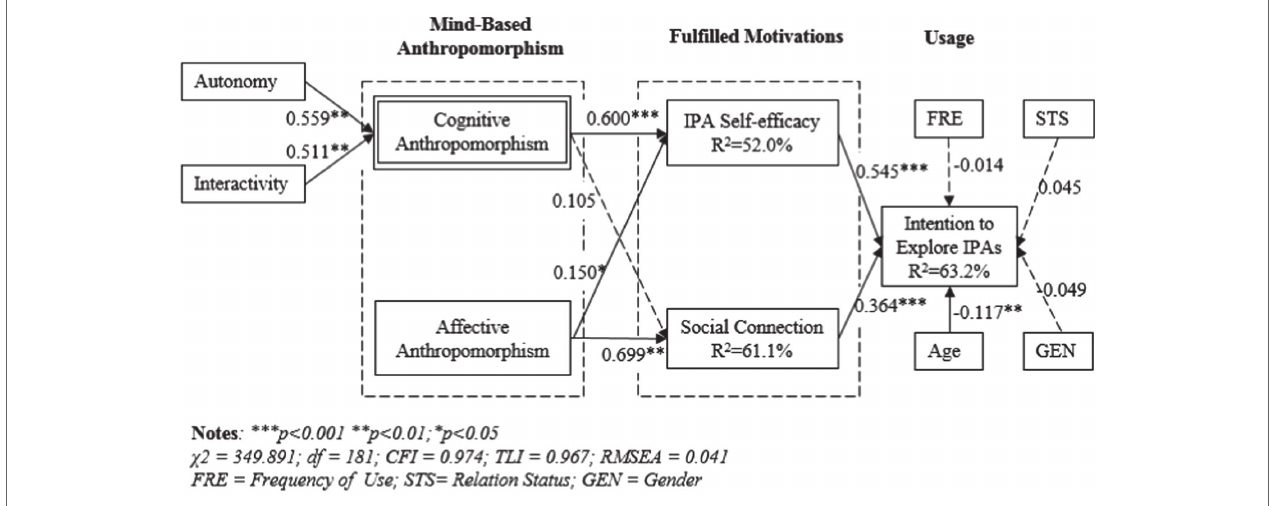
FIGURE 2 | Structural model results.